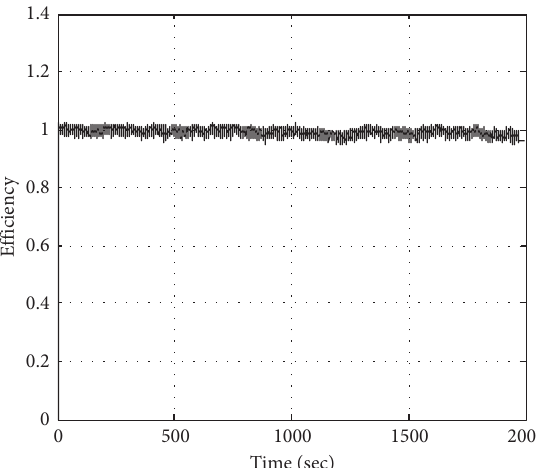
Figure 14: Efficiency of the Pv system.